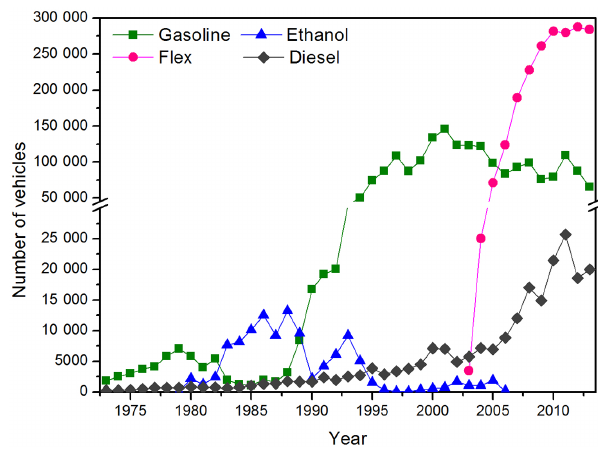
Figure 1. Annual registrations of new vehicles in the city of São